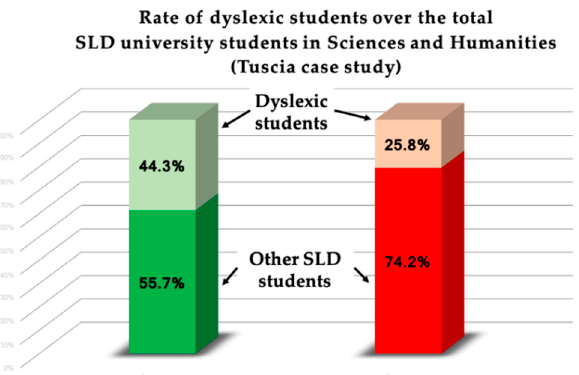
Figure 4. Rate of dyslexic students over the total number of SLD university students in sciences and humanities, according to the Tuscia case study.